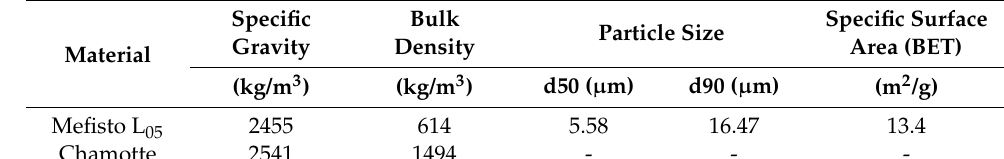
Table 2. Physical properties of raw materials.